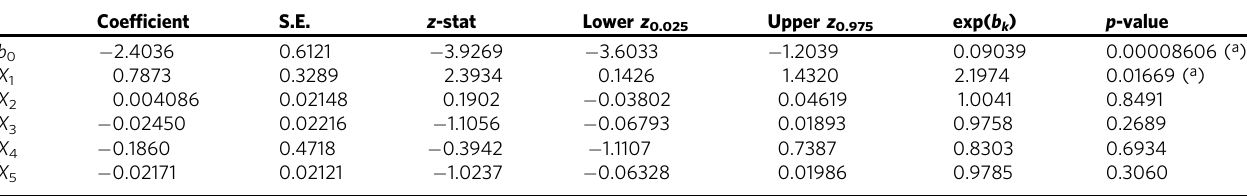
Table 6 Coef fi cients relating category 1 to category 0 of gender. Source: Own elaboration. Coef fi cient S.E.